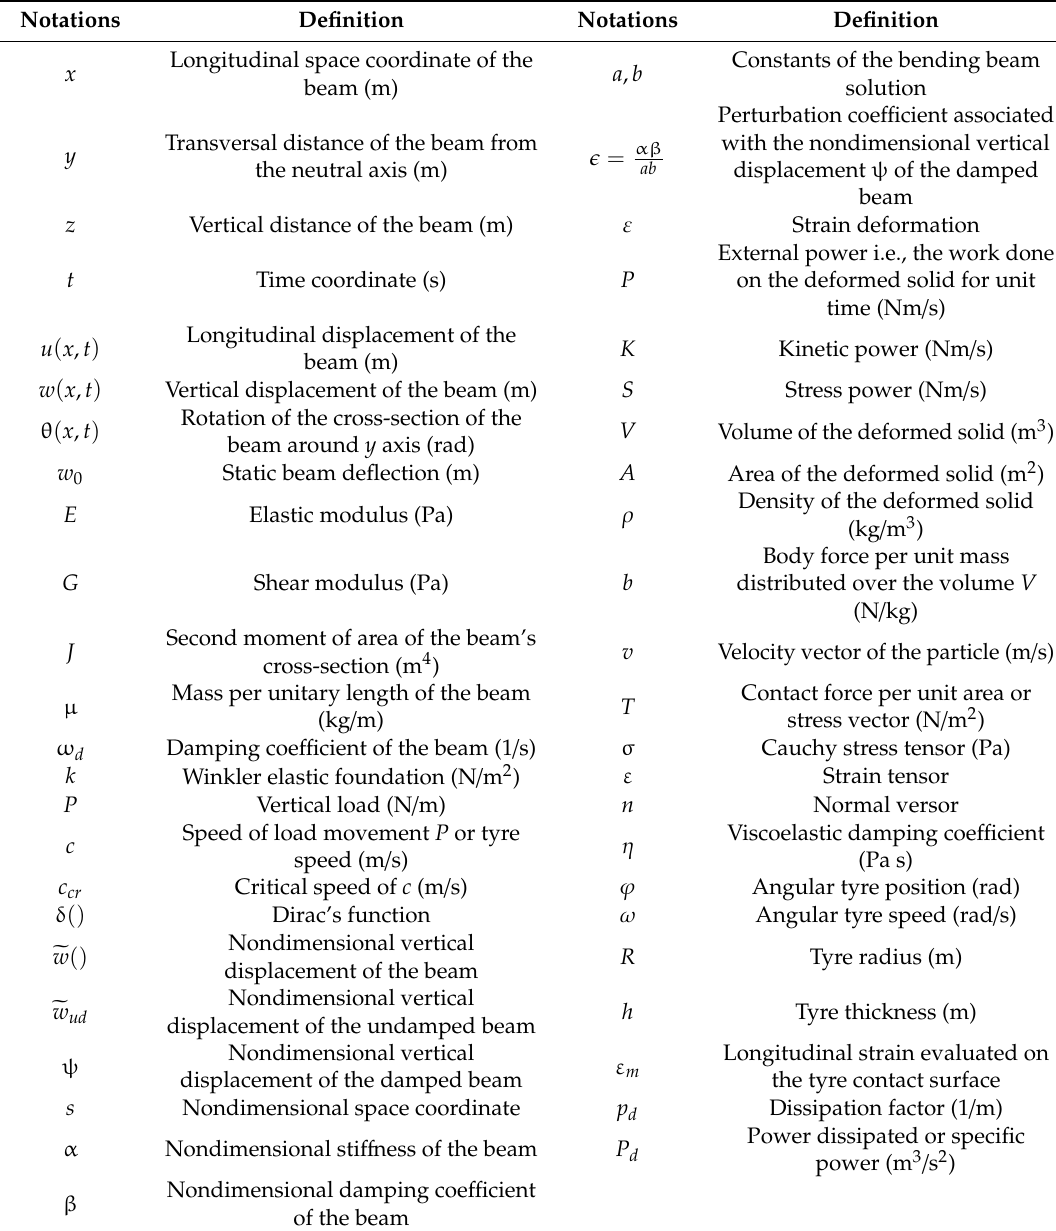
Table 1. Metamathematical